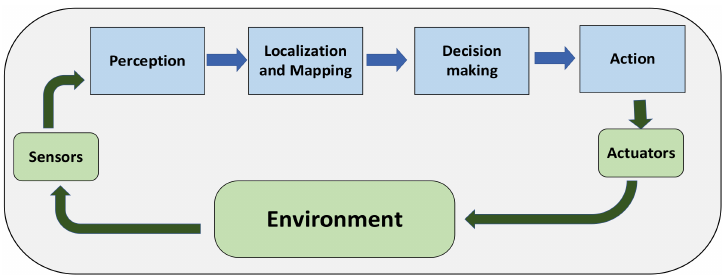
Figure 1. Overview of the autonomous navigation process.